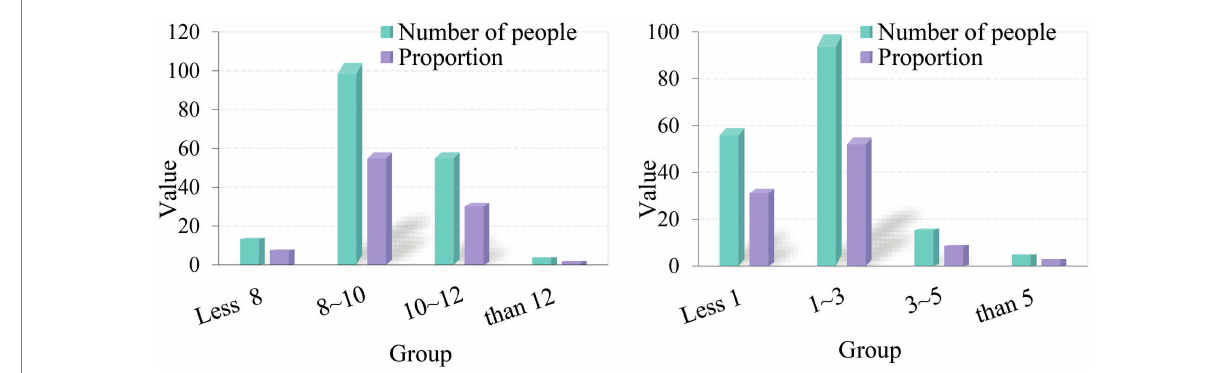
FIGURE 6 Statistical analysis of working hours and years of express delivery employees.